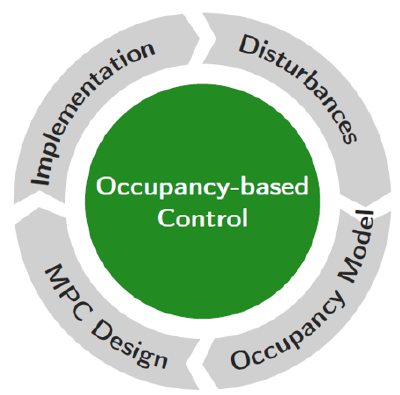
Figure 1. Scheme of occupancy-based